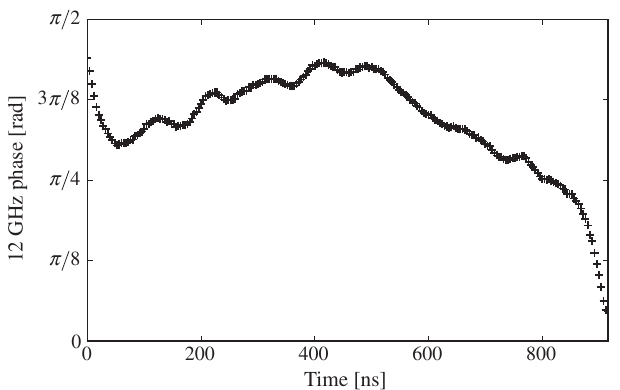
FIG. 5. 12 GHz phase measured in a PETS for an uncombined beam, which itself has a 3 GHz bunch structure and a longer bunch train than the combined